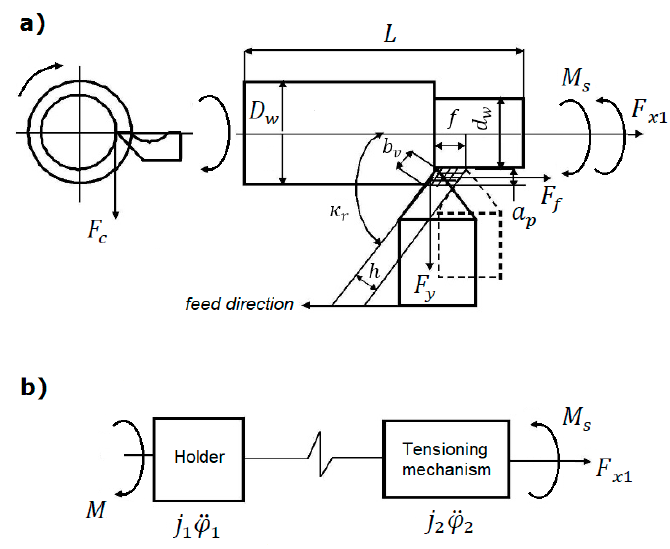
Figure 2. Calculation scheme of the machining system ( а ), model of the machining system ( b ).